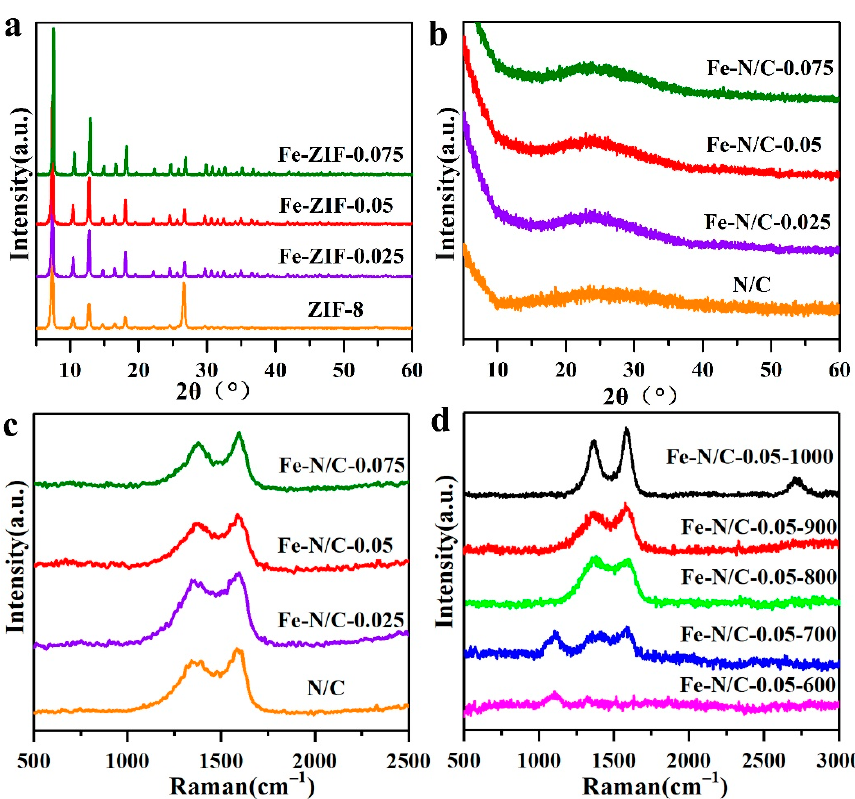
Figure 1. ( a ) The XRD patterns of the precursors with different Fe feeding, ( b ) XRD patterns, ( c ) Raman spectra of products synthesized under 900 °C, and ( d ) Raman spectra of products by carbonizing Fe–ZIF–0.05 precursors at different temperatures.